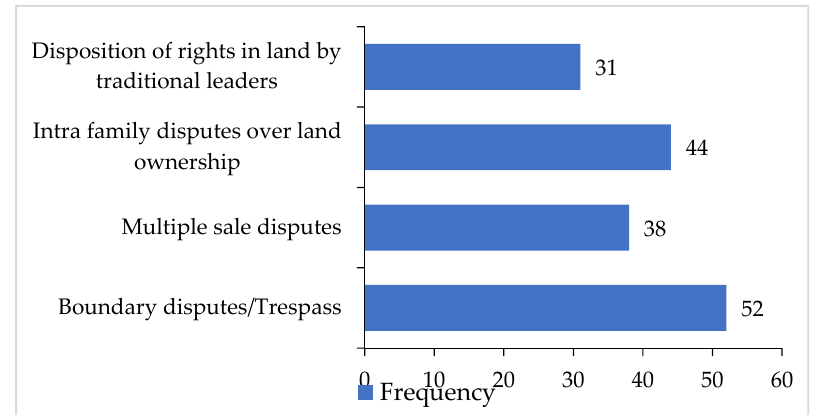
Figure 5. Types of customary land rights disputes in Trede (source: Field survey, 2018).